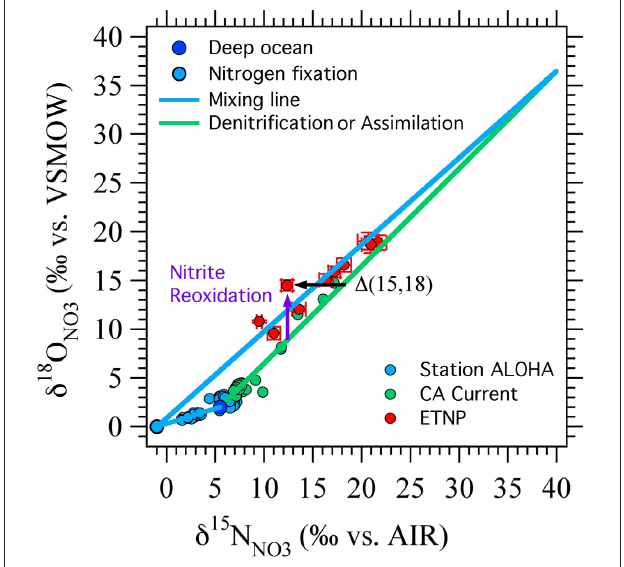
FIGURE 4 | (cid:2)( 15 , 18 ) as originally devised. A schematic showing the effects of nitrate reduction, assimilation, and input of NO − 3 from nitrogen , δ 18 O NO , and the nitrate isotope fixation linked to nitrification on δ 15 N NO 3 3 anomaly, (cid:2)( 15 , 18 ) (black arrow). Deep ocean nitrate (dark blue circle) starts of 5 (cid:2) and δ 18 O NO of 2 (cid:2) . Nitrate assimilation and with δ 15 N NO 3 3 denitrification increase δ 15 N and δ 18 O in a 1:1 ratio ((Granger et al., 2004, 2008, 2010); green line). Remineralization of newly fixed N is assumed to of − 1 (cid:2) and δ 18 O NO of 0 (cid:2) (light blue circle, blue add NO − 3 with δ 15 N NO 3 3 mixing lines). Nitrite reoxidation is expected to generally increase δ 18 O NO 3 relative to δ 15 N NO because of the oxygen isotope systematics of nitrate 3 reduction and nitrite oxidation (purple arrow). Data from station ALOHA (Casciotti et al., 2008), California Current (Santoro et al., 2010) and ETNP (Casciotti and McIlvin, 2007) are shown for comparison.